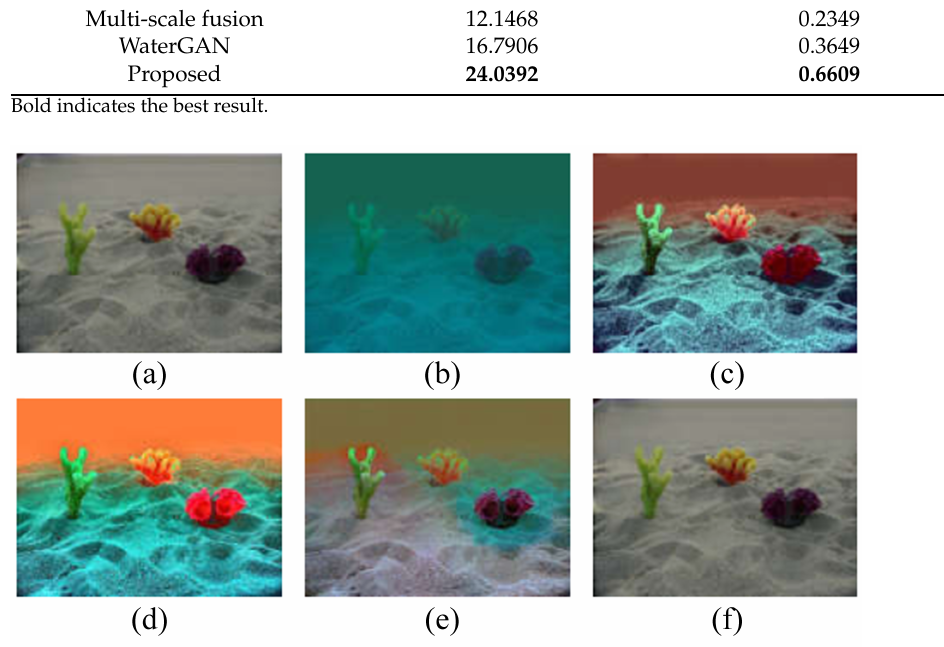
Figure 9. Output results of different methods. ( a ) Original. ( b ) Generated underwater image. ( c ) Retinex-based. ( d ) Multi-scale fusion. ( e ) WaterGAN. ( f ) Proposed.